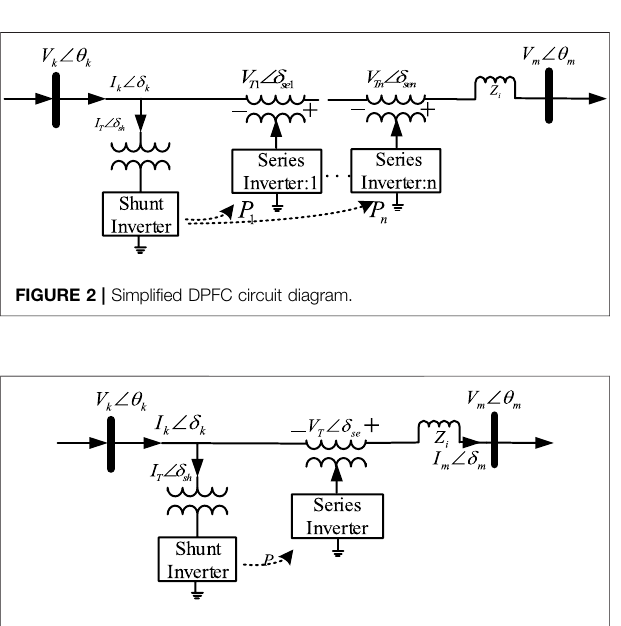
FIGURE 3 | Simpli fi ed DPFC model.